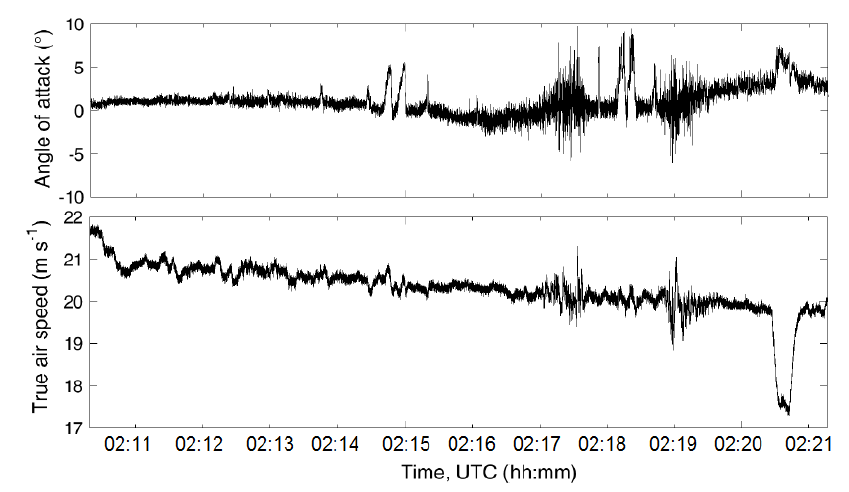
Figure 12. Time series of the angle of attack ( top ) and the true air speed ( bottom ) from the M 2 AV during icing on 2 August